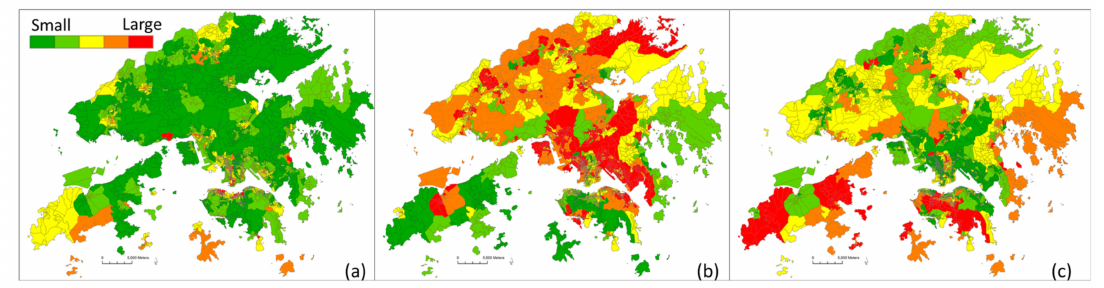
Figure 3. Commuting mode choice for each street block illustrated as a percentage in three categories: walking ( a ), public transit ( b ), and automobile ( c